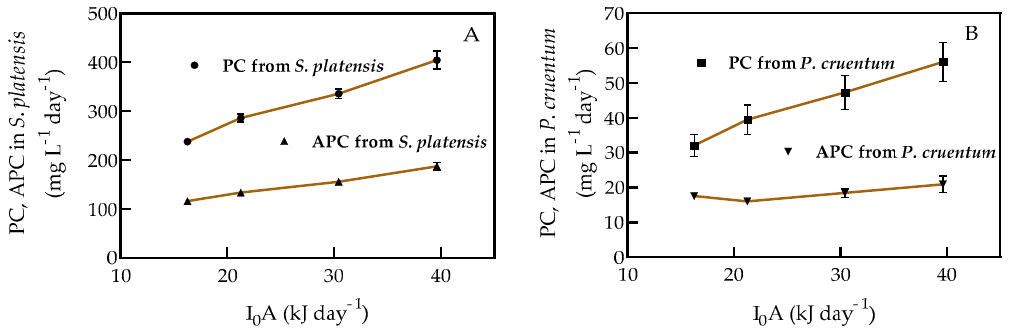
Figure 9. PC and APC production in ( A ) S. platensis and ( B ) P. cruentum under continuous cultures at different light intensities. Each point indicates the mean of 3 replicates ( p < 0.05).